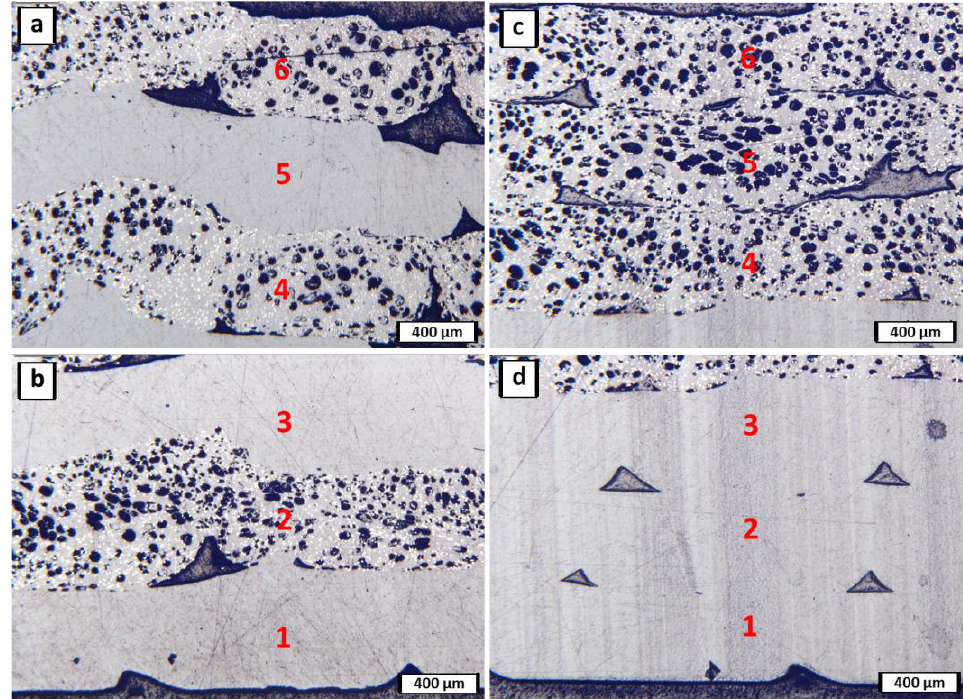
Figure 6. Micrographs of the top and bottom layers of ULTEM 9085 + ULTEM 9085 CF multi-material with layering pattern ABABAB ( a , b ) and AAABBB ( c , d ). Layers are labeled 1 through 6 with 1 being the bottom layer.